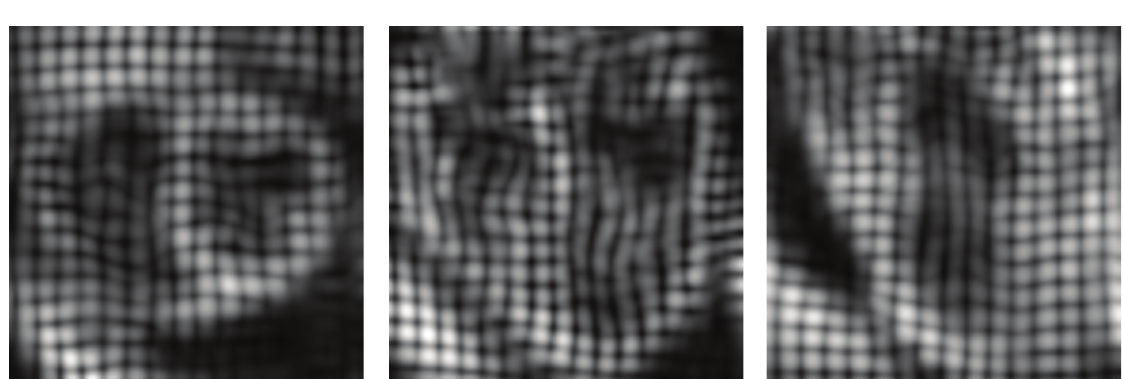
Figure 5: Cardiac tagged MR images, frame 3. Rows 1 and 2 from left to right: Short axis view with horizontal tags, 2 long axis views with vertical and horizontal tags, respectively. Row 3: Combination of the image planes. Row 4 displays the outcome of the combination of image planes. The images exhibit a chessboard